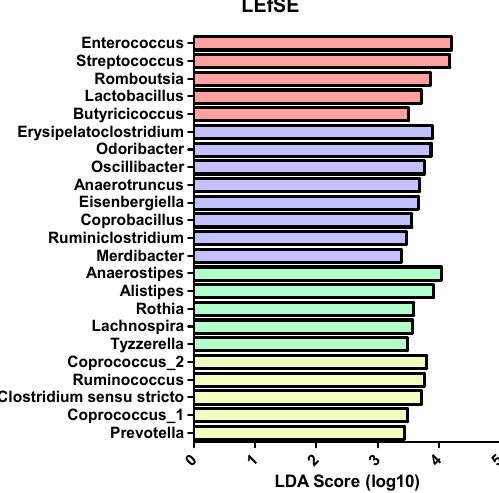
Figure 5. Linear discriminant analysis-effect size (LEfse) results of SC-CIP (red), CIP controls (violet), cirrhosis (green) and healthy (Yellow) groups. The presented genera are associated with microbiome composition of the respective group. The length of the bar shows the logarithmic linear discriminant analysis (LDA) score.